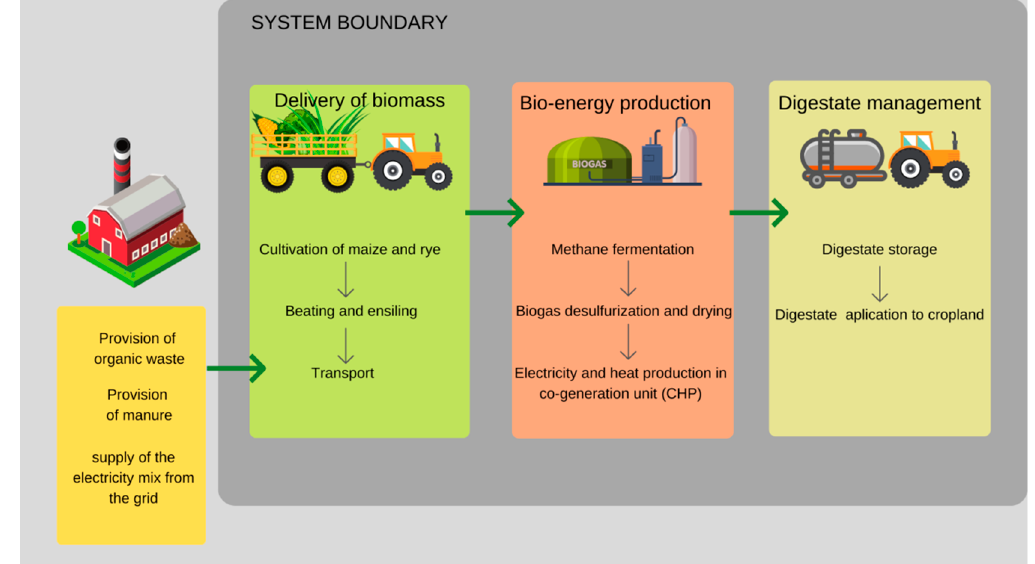
Figure 1. System boundary of the bioenergy production in biogas plant. Table 1. Life cycle inventory data of biomass input and delivery in relation to annual operations. Biogas Plant